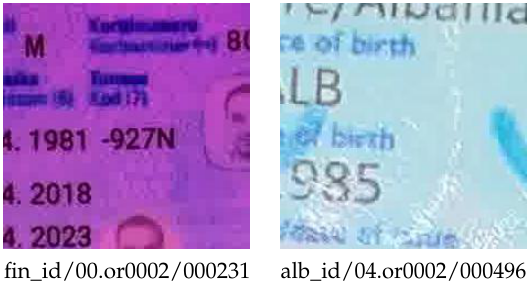
Figure 8. FP error samples for CNN-based screen recapture